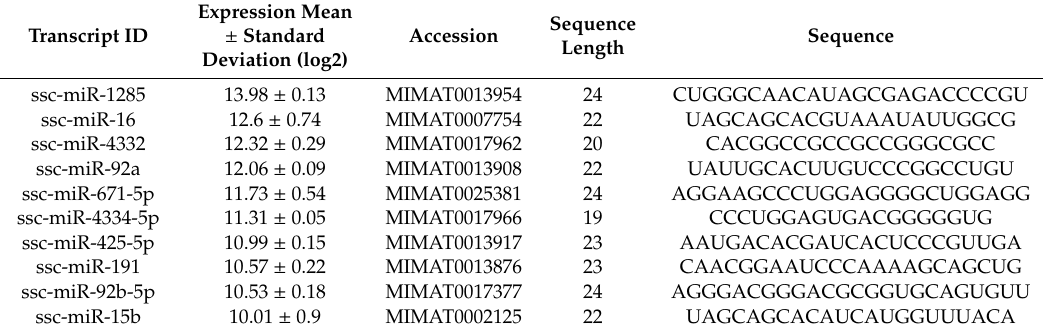
Table 1. Expression (Mean ± Standard Deviation of the log2 average expression or transcript detection) of Sus scrofa specific miRNAs detected by the GeneChip ™ miRNA 4.0 Array (ThermoFisher Scientific) in spermatozoa retrieved from the sperm-rich fraction (SRF) of the ejaculate of healthy mature boars ( n = 3). The miRNA is designed to interrogate all mature miRNA sequences in miRBase v20. The array includes 30.424 mature miRNA (all organisms) and we select specifically 10 of the 326 Sus scrofa -specific miRNAs included in the array with expression value >